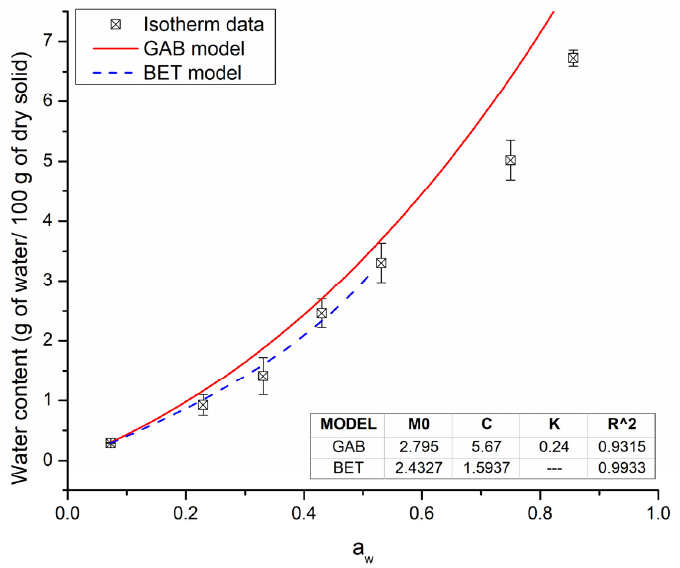
Figure 2. Water adsorption isotherm at 35 °C for the functional food blend MX-IN:25-75.